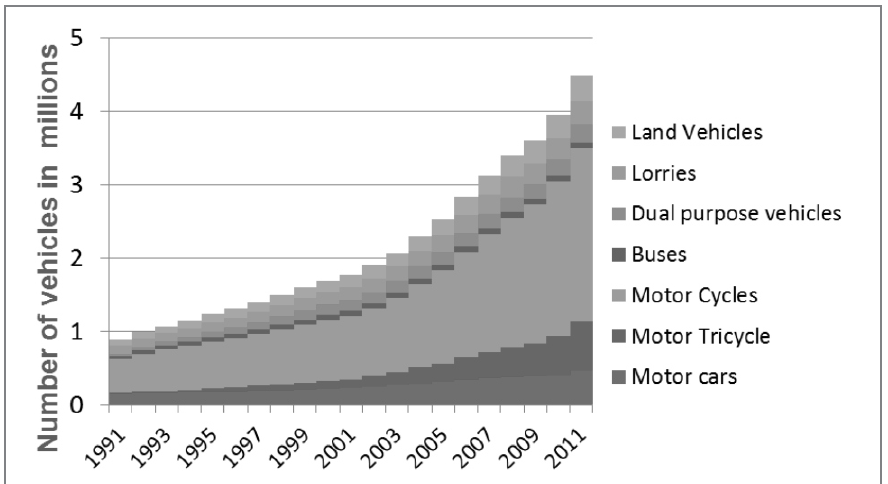
Figure 1: Vehicle growth in Sri Lanka from 1991 to 2011